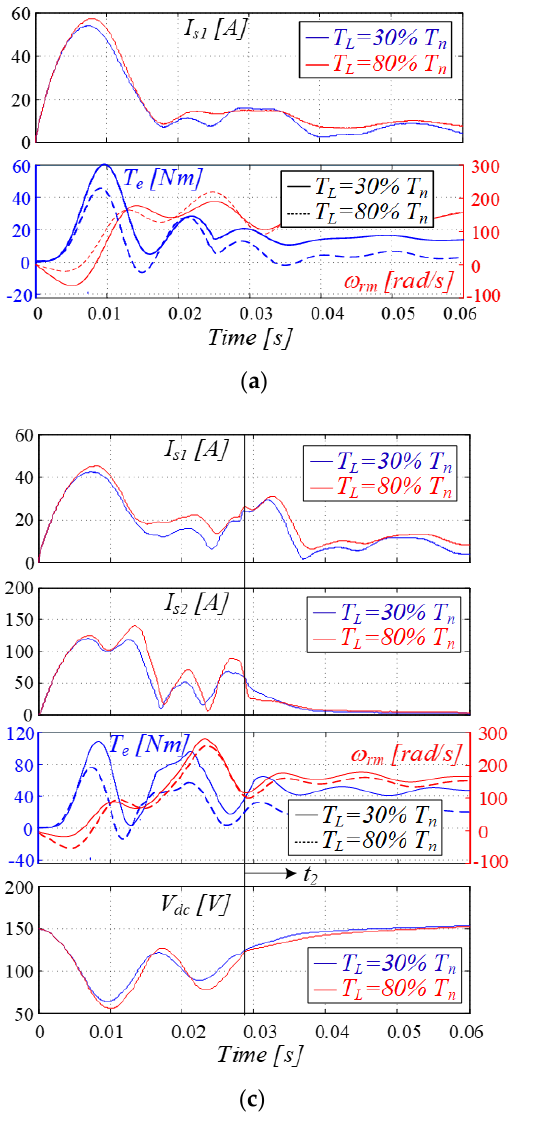
Figure 16. Induction motor start-up current: ( a ) standard IM (3 kW), ( b ) standard IM (15 kW), ( c ) 3 kW with the proposed technique, and ( d ) 15 kW with the proposed technique.